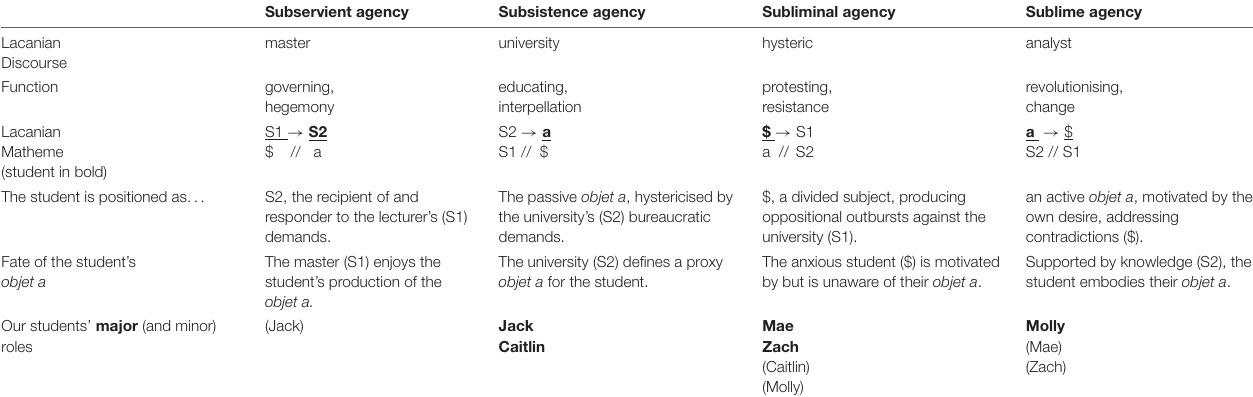
TABLE 1 | Four modes of student